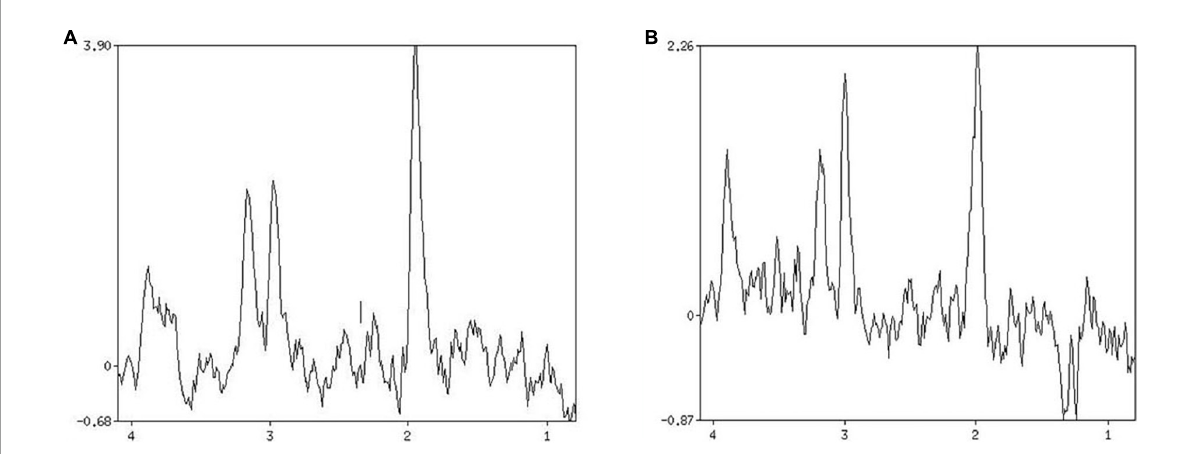
and anaerobic metabolism. Therefore, Stroke patients who are also diabetic often have more severe clinical symptoms and a poorer